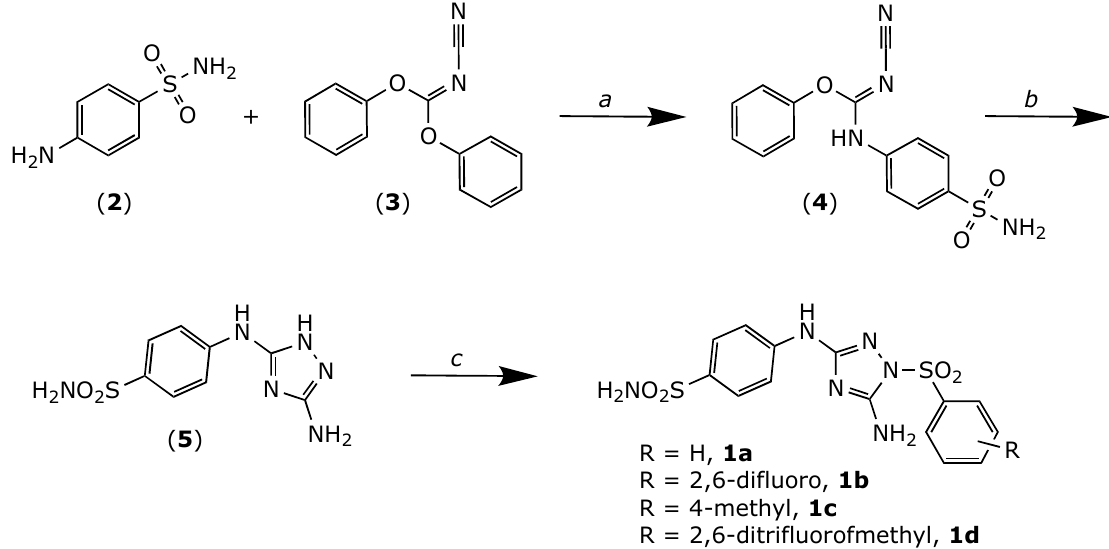
Figure 2. Chemical synthesis of compounds 1a–d . Reagents and conditions: ( a ) iPrOH, heated in a sealed tube at 90 °C, 3 h. ( b ) NH 2 NH 2 , THF, RT, 12 h. ( c ) Pyridine, substituted sulfonyl chlorides, RT, overnight.